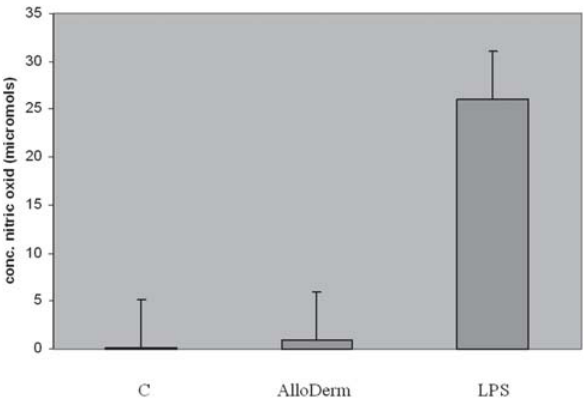
FIGURE 1- Production of nitric oxide by peritoneal macrophages cultured with medium (C), acellular dermal matrix and lypopolysaccharide (1x10 3 mg/well), by 24 hours of incubation at 37 degree. The results were expressed as the mean +/- SD of quadruplicate from five determinations